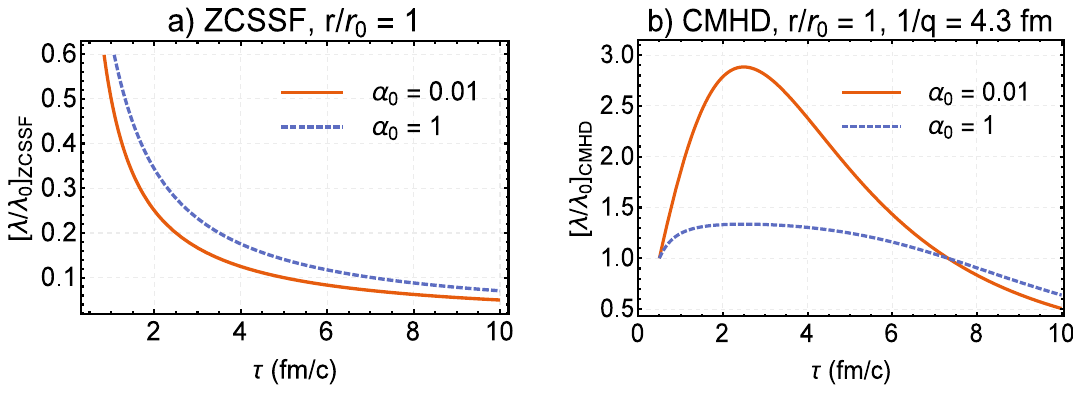
Figure 5 . (color online). The τ dependence of λ/λ 0 for the ZCSSF solution (panel a) and the CMHD solution (panel b) is plotted at r = r 0 and for α 0 = 0 . 01 (solid orange curves) and α 0 = 1 (dashed blue curves). For the CMHD solution q is chosen to be q = 1 / 4 . 3 fm − 1 . Whereas [ λ/λ 0 ] ZCSSF decreases with increasing τ , [ λ/λ 0 ] CMHD exhibits a maximum at τ 4 τ 0 , and then slowly decreases ∼ with increasing τ . This maximum becomes larger, the smaller α 0 is